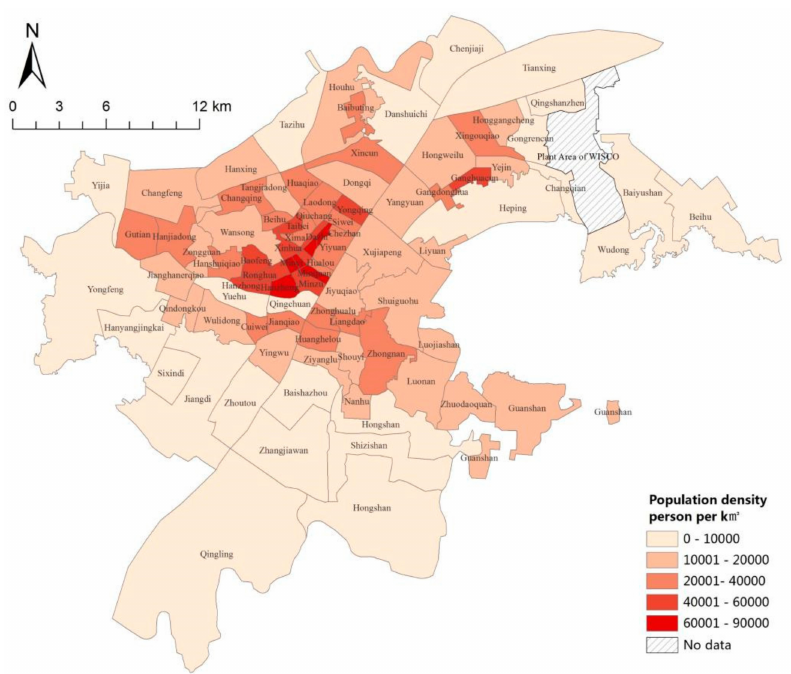
Figure 2. The street-level population density of the central area of Wuhan City in